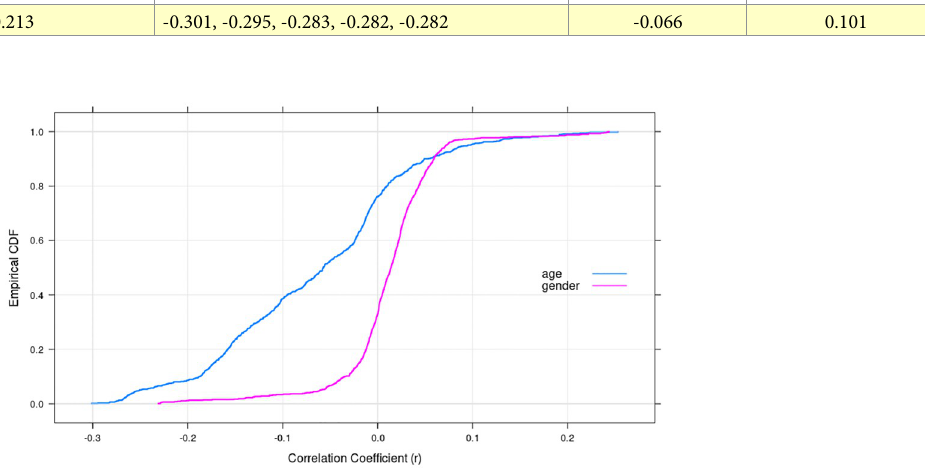
Fig 4. CDF for correlation of 749 attributes with response variables.